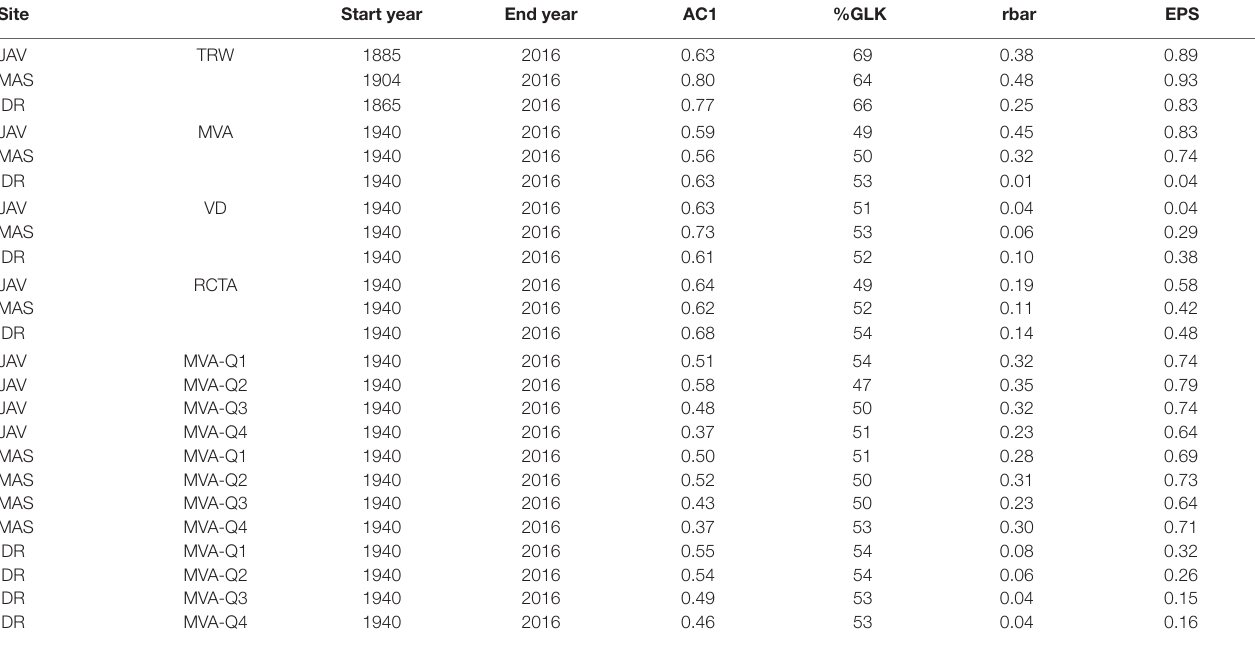
TABLE 2 | Tree ring width and wood anatomy chronologies and descriptive statistics: first-order autocorrelation (AC1), Gleichläufigkeit coefficient (%GLK), mean inter- series correlation (rbar), and expressed population signal (EPS) for the selected sites; Javornik (JAV), Masun (MAS), and Idrija (IDR).